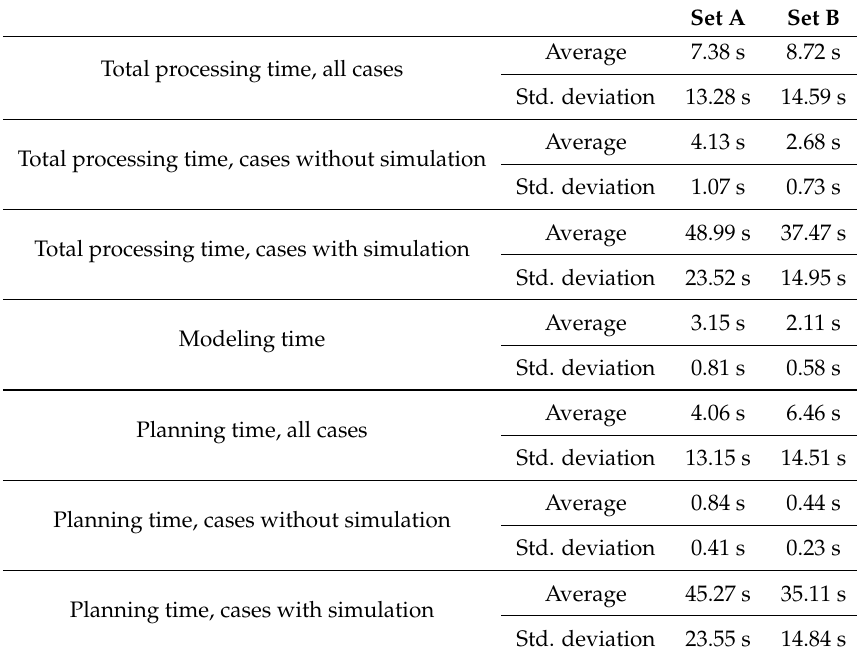
Table 9. Statistics for the execution times of different sets of